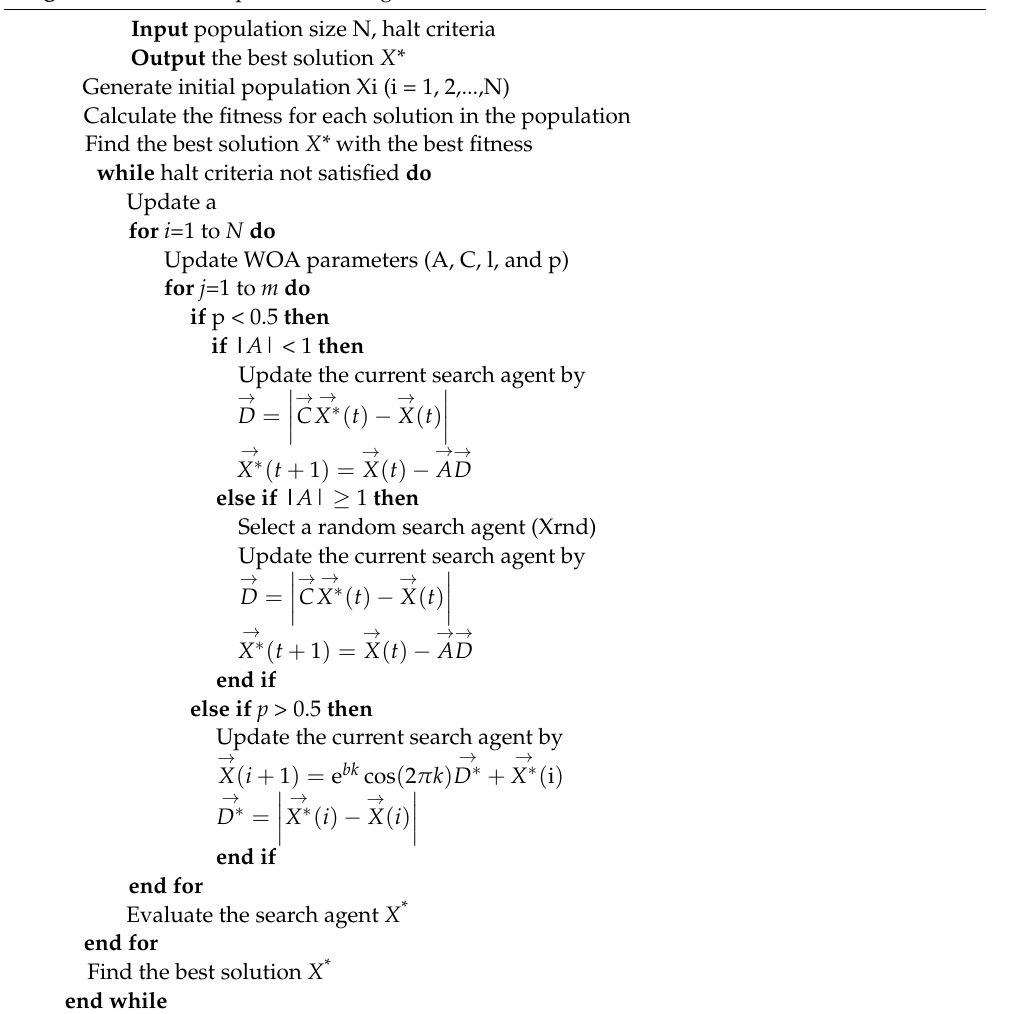
Algorithm 1 Whale Optimization